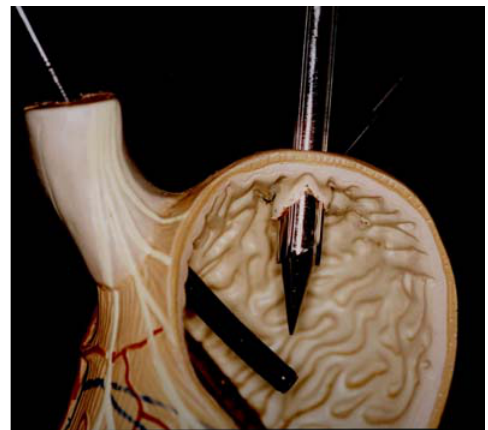
FIGURE 8 - Schematic view of urological trocar been introduced on the gastric lumem.